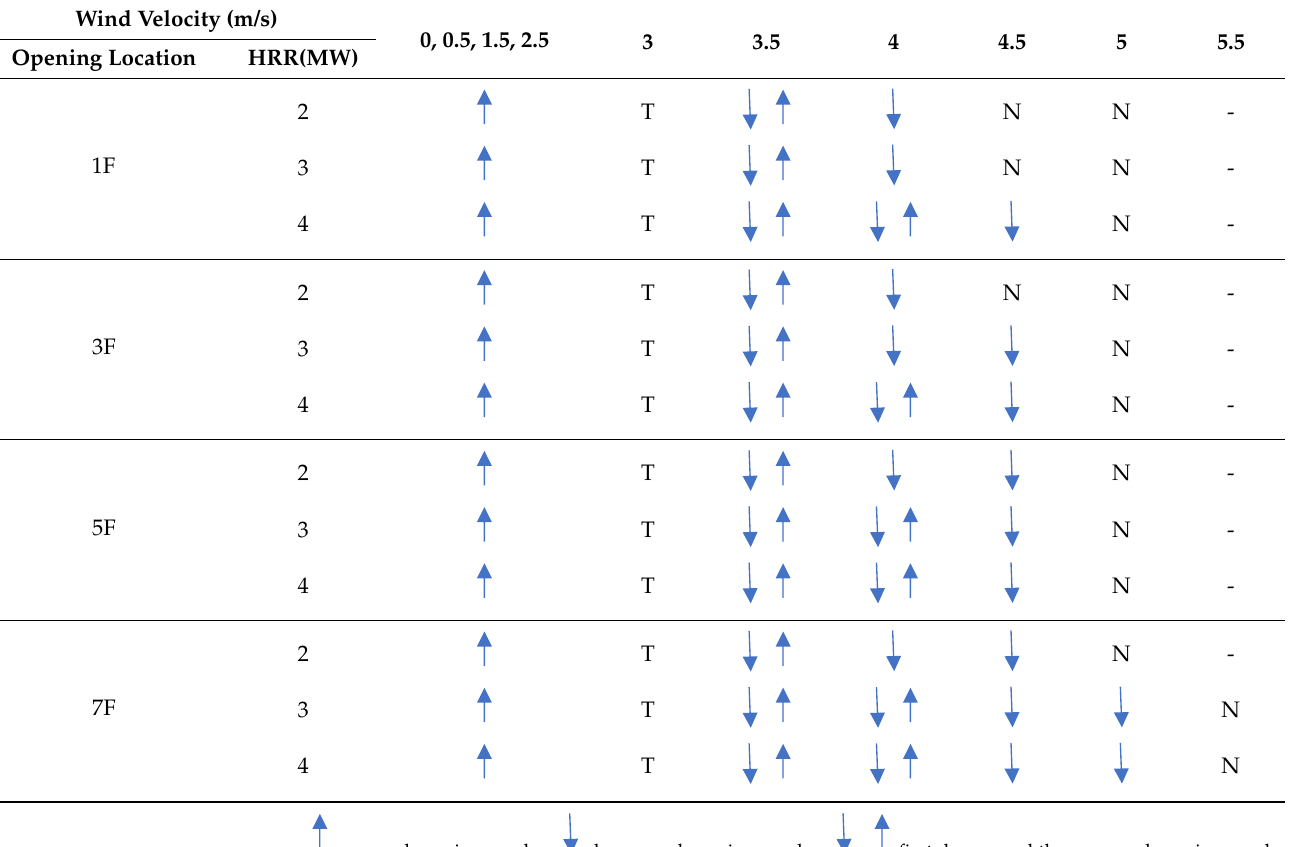
upward moving smoke, downward moving smoke, first downward then upward moving smoke. T, critical transition condition of the upward moving smoke; N, no smoke inside the the staircase.